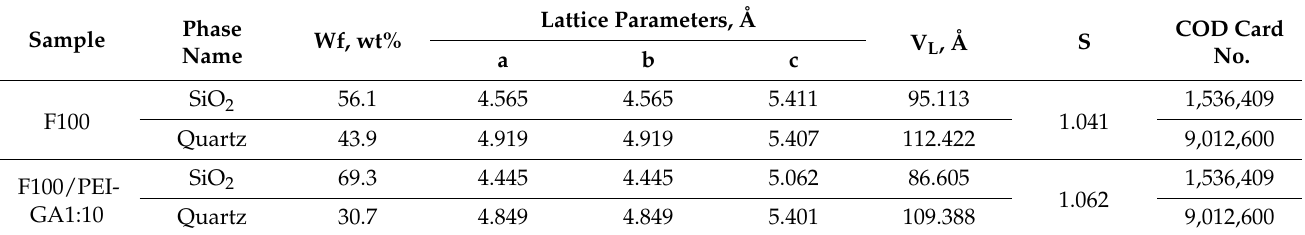
Table 1. F100/PEI-GA 1:10 samples.